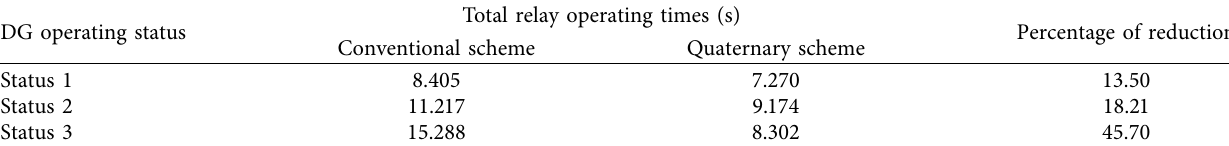
Table 13: Comparison of the total relay operating times of different protection schemes in islanded